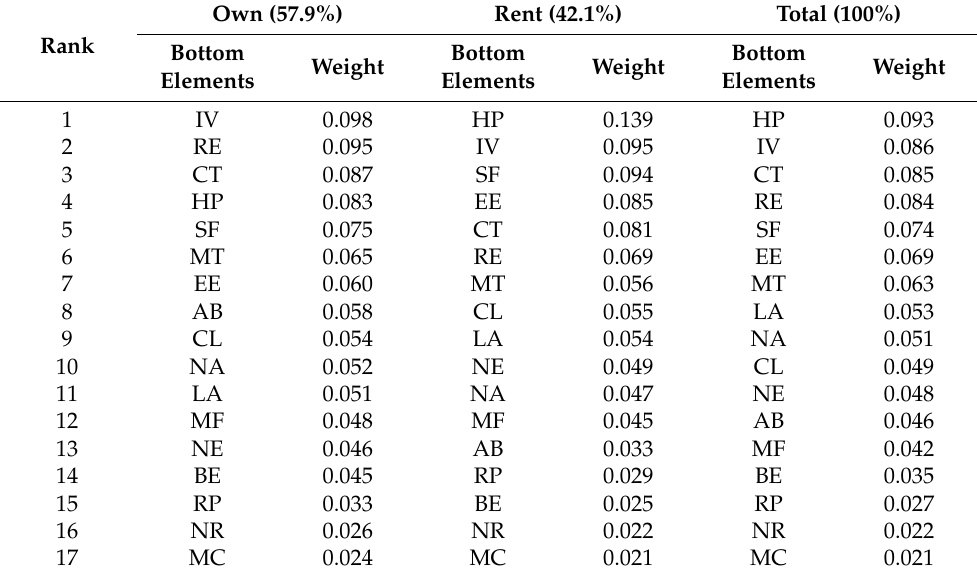
Table 10. The AHP Analysis of Ownership Preference.